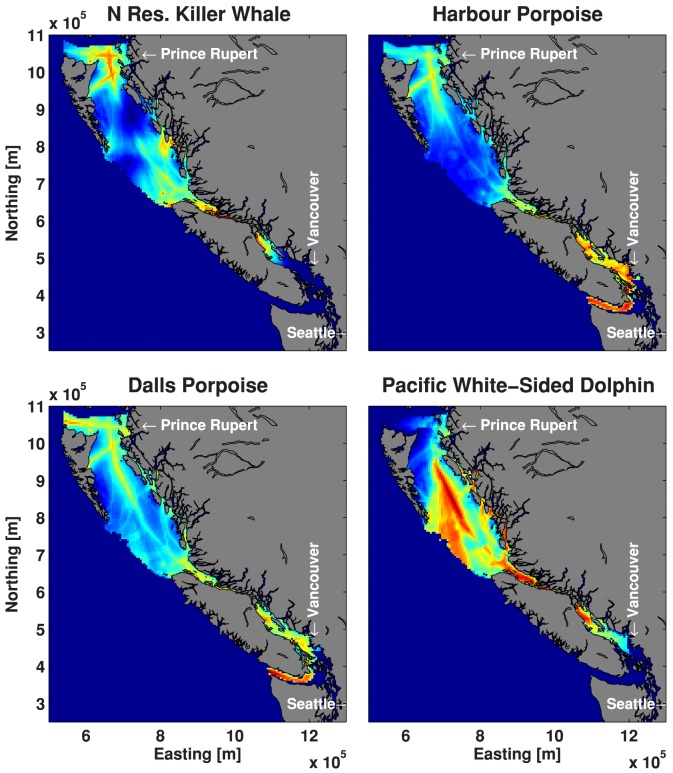
Map of ship noise and animal hotspots for four odontocete species.